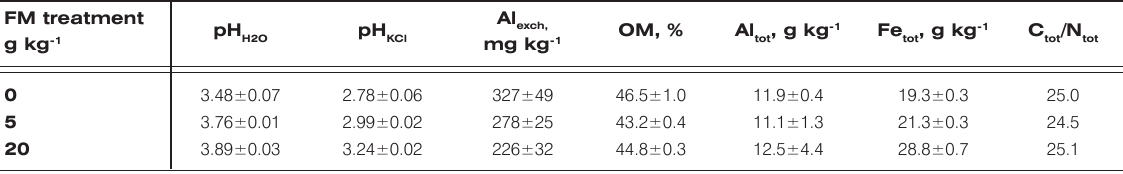
Table 1. Basic properties of soils (control (0) and after ferruginous mineral (FM) treatment). FM treatment